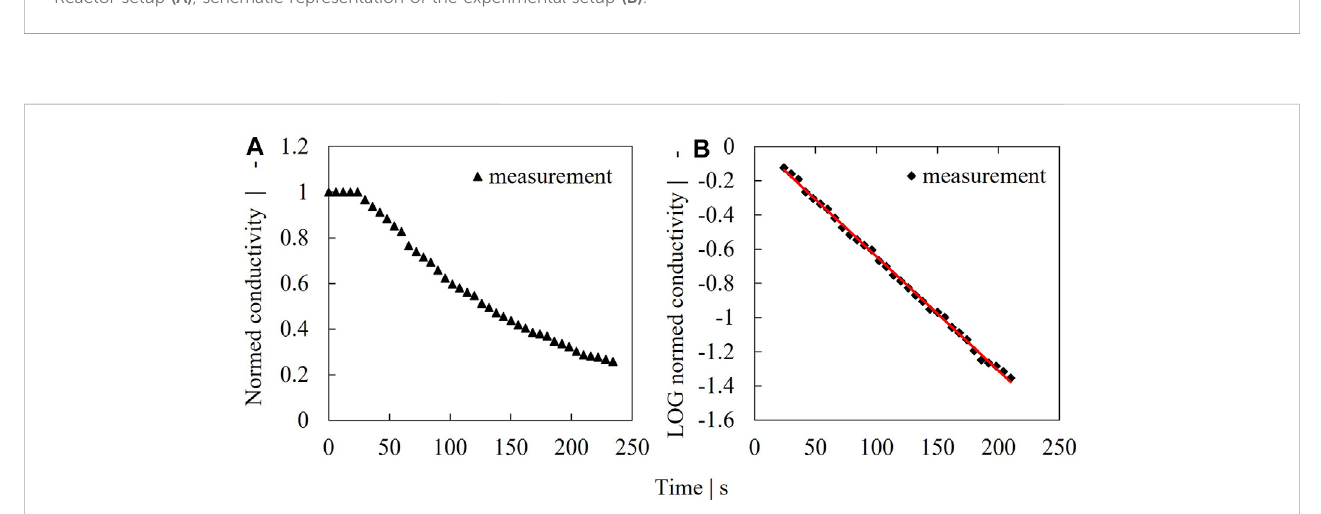
FIGURE 2 Example for dilution rate determination. Measured conductivity signal at an impeller speed of 250 rpm (A) , logarithmized concentration (B)